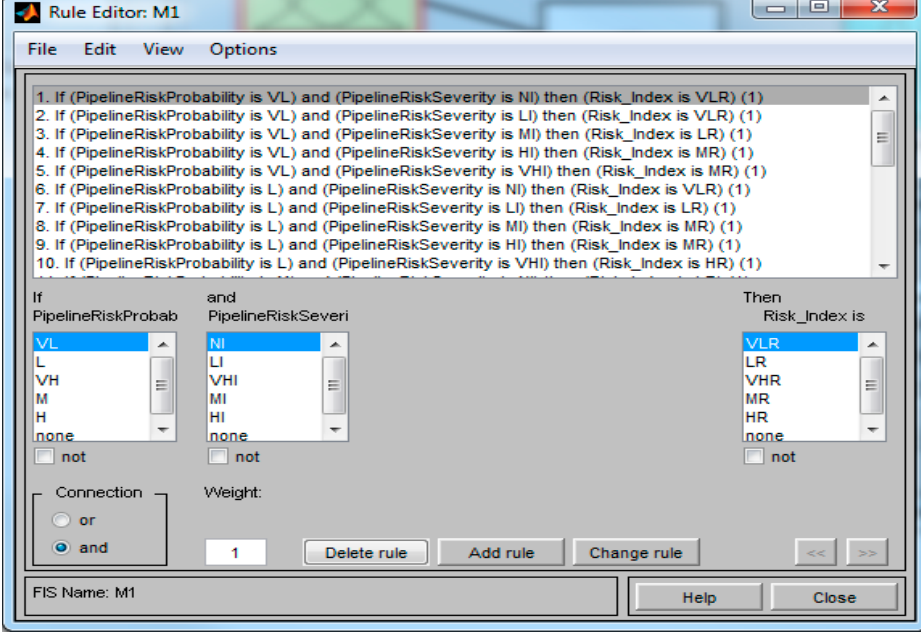
Figure 9. Rule editor for specifying average rule-based method rules.